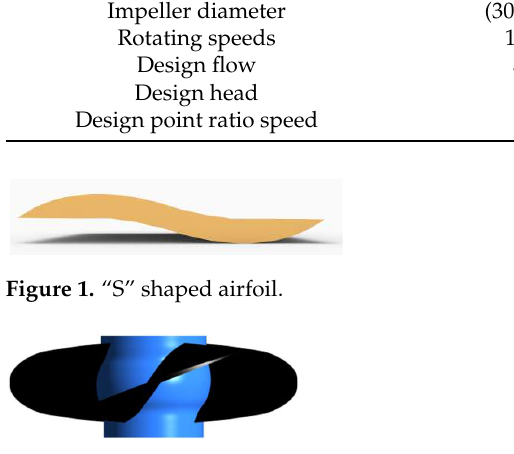
Figure 2. Impeller of bidirectional axial flow pump.